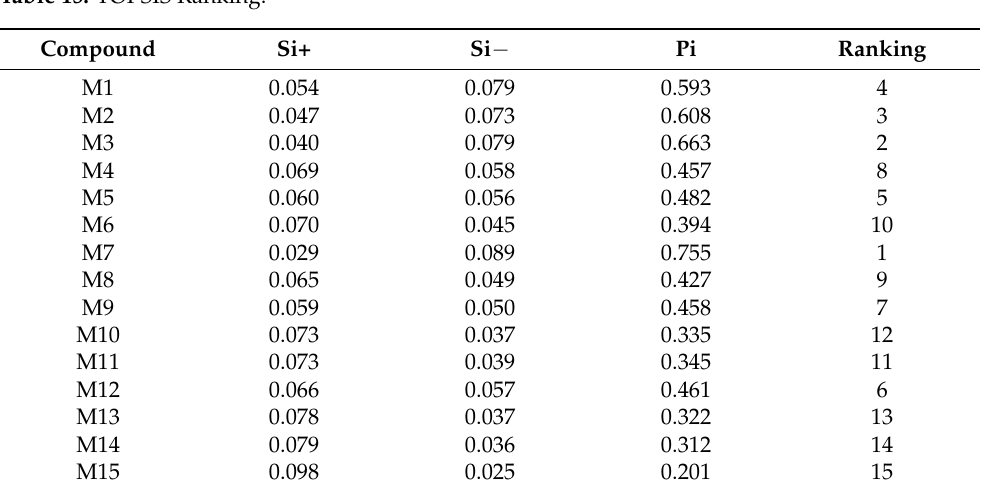
Table 15. TOPSIS Ranking.